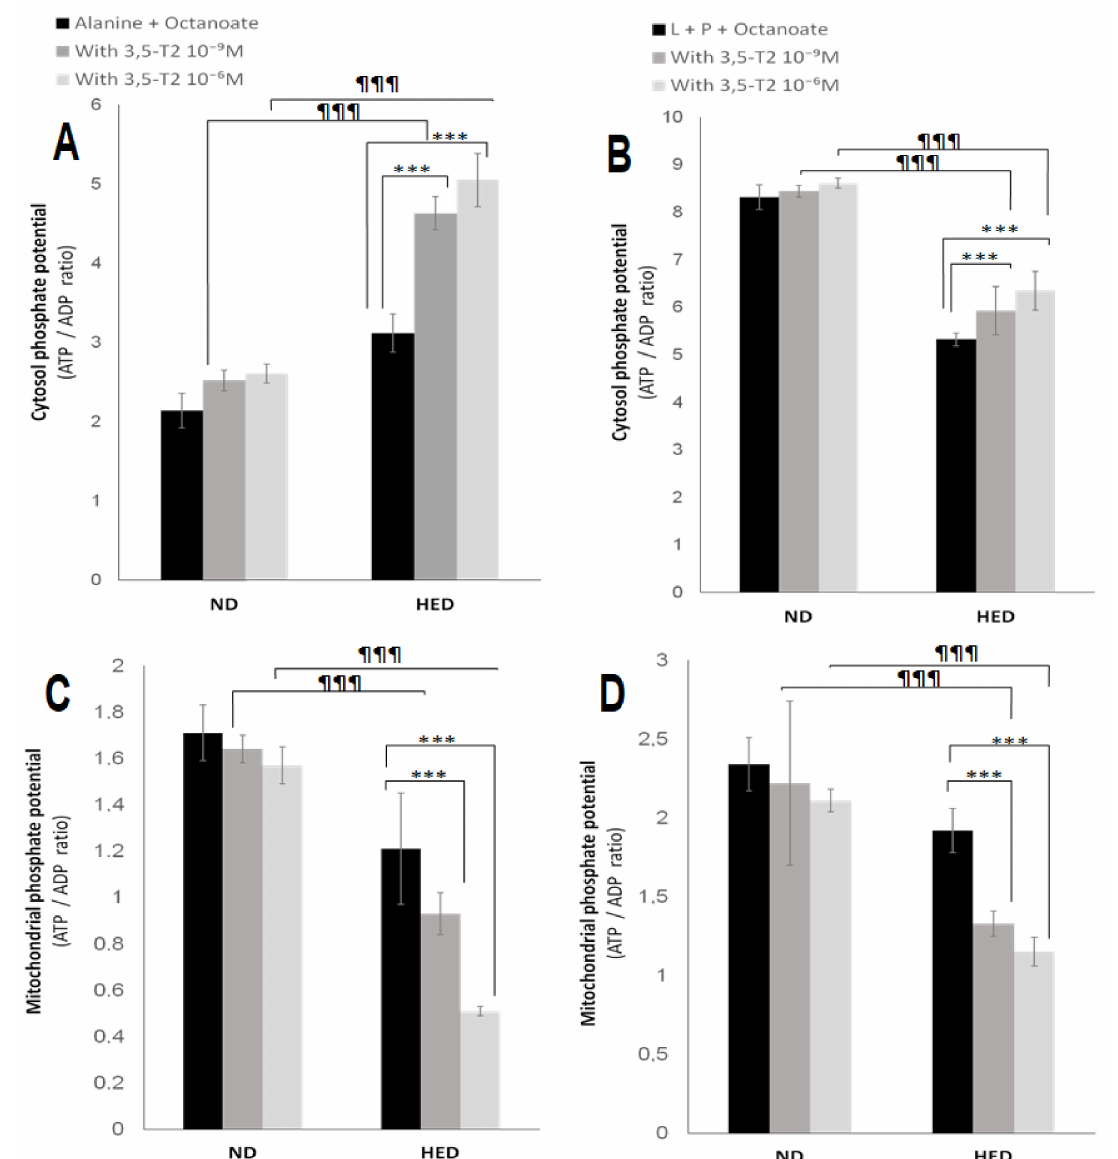
Figure 4. Effects of 3,5-T2 on both cytosolic and mitochondrial phosphate potential (ATP/ADP) in isolated hepatocytes from experimental P. obesus fed ND or HED. ND: Natural Diet, HED: High Energy Diet. Freshly isolated hepatocytes from 16 h-fasted P. obesus were incubated in Krebs/bicarbonate, buffer containing alanine or lactate (L) + pyruvate (P) together with octanoate in the absence or presence of 3,5-T2 (10 − 9 or 10 − 6 M). Cytosol ( A , B ) and mitochondrial ( C , D ) phosphate potential is represented by the ATP/ADP ratio. Data are expressed as mean ± SEM. *** p < 0.001 compared 3,5-T2-treated group versus HED placebo group. ¶¶¶ p < 0.001 compared 3,5-T2-treated group versus ND placebo group. ns: no